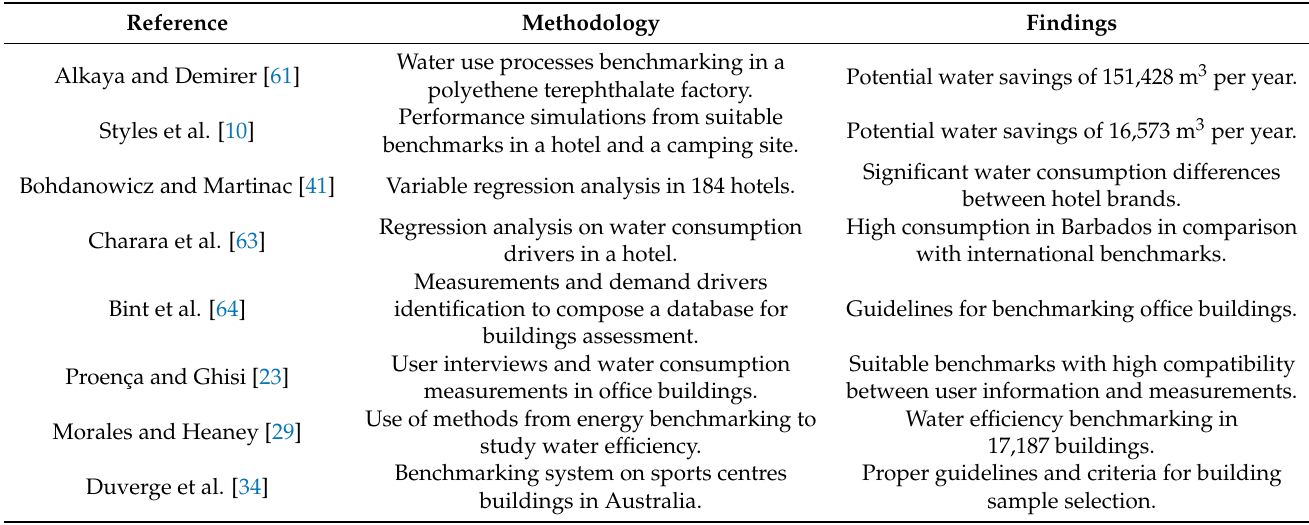
Table 3. Results from water-use benchmarking in commercial